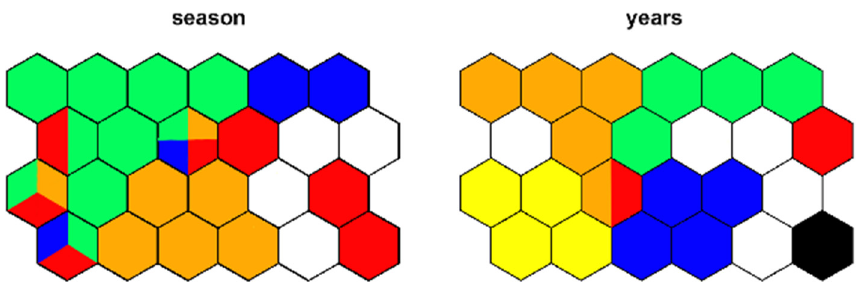
Figure 19. Supervised map of sites clustered, respectively, using season (green, spring; red, summer; orange, autumn; blue, winter) and year as external variable.